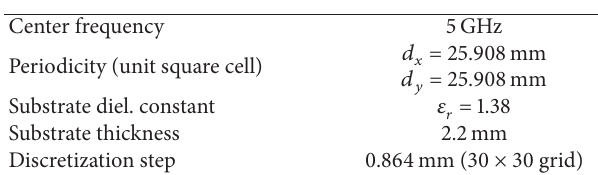
Table 3: Fixed parameters of the periodic structure in the S- frequency